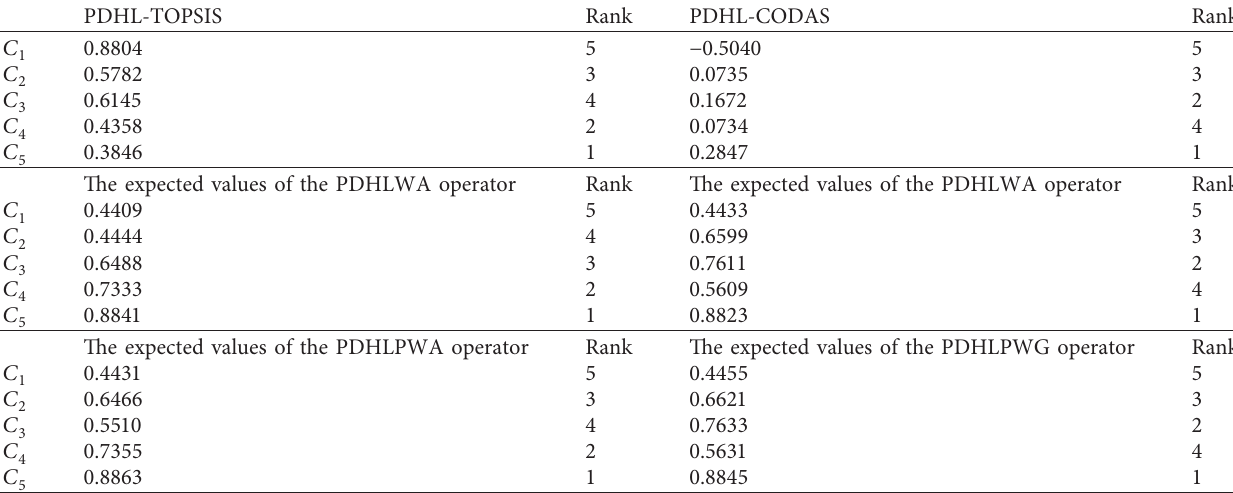
Table 13: The numerical results and rank were derived by the